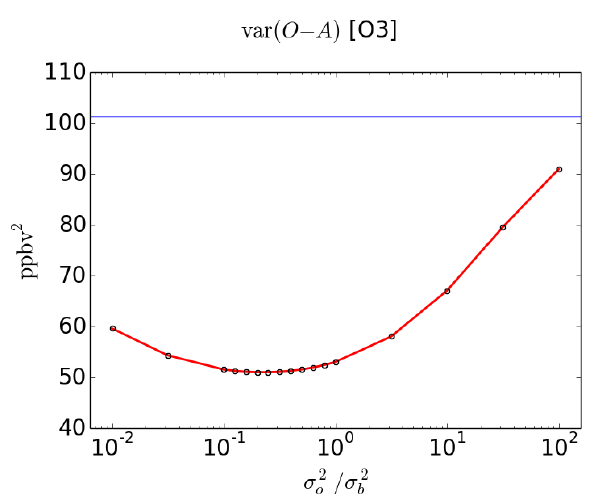
Figure 2. Red line, variance of observation-minus-analysis of O 3 in passive observation space. Blue line, variance of observation-minus-model. Table 1. Input error statistics for the first experiment and optimized variance ratio experiment.